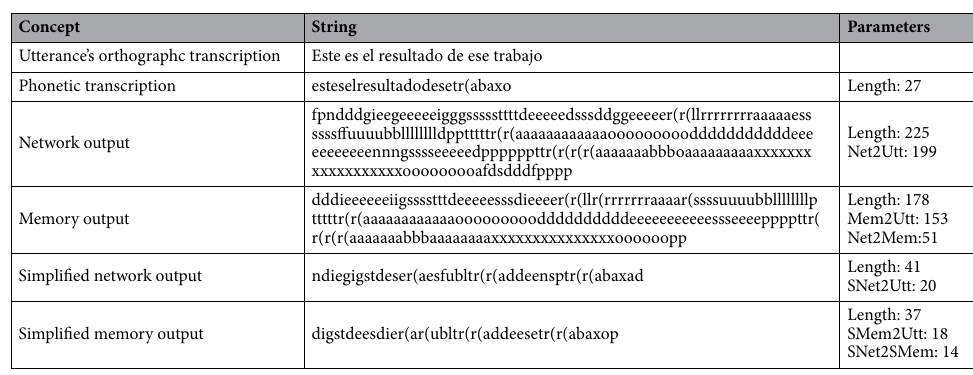
Table 5. Example of a recognized utterance and the distances between the strings recognized by the memory and the network to the original phonetic transcription.